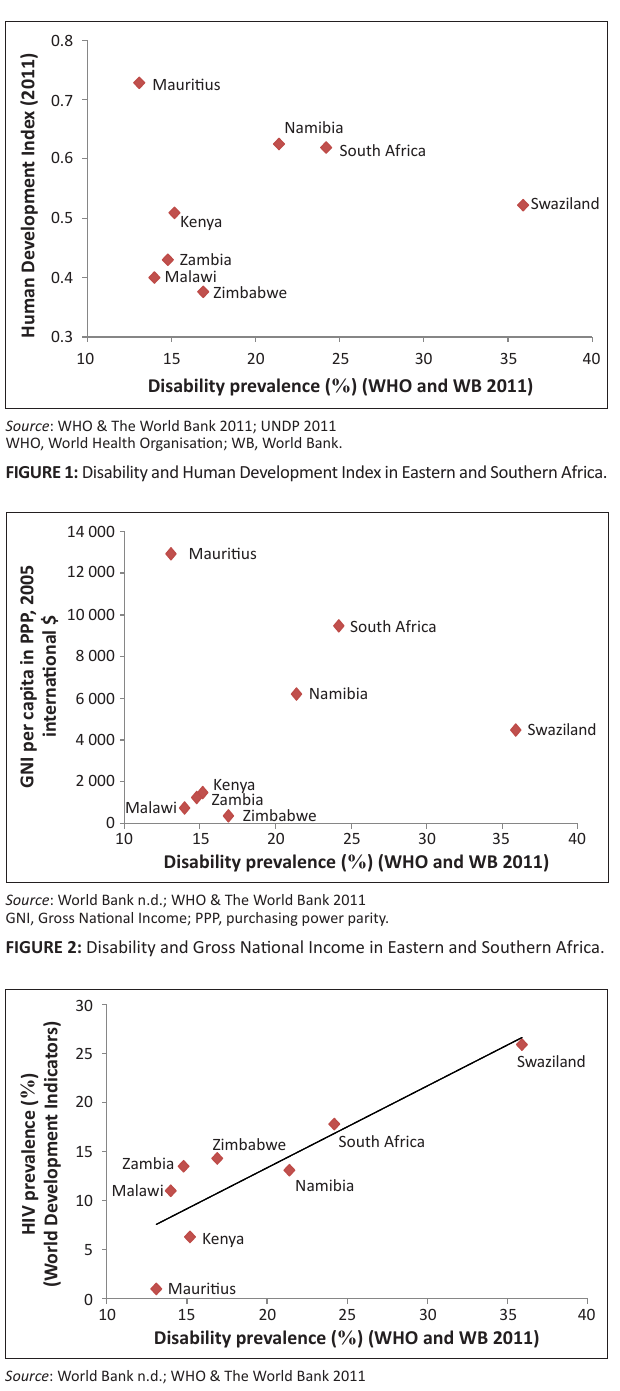
FIGURE 3 : Disability and